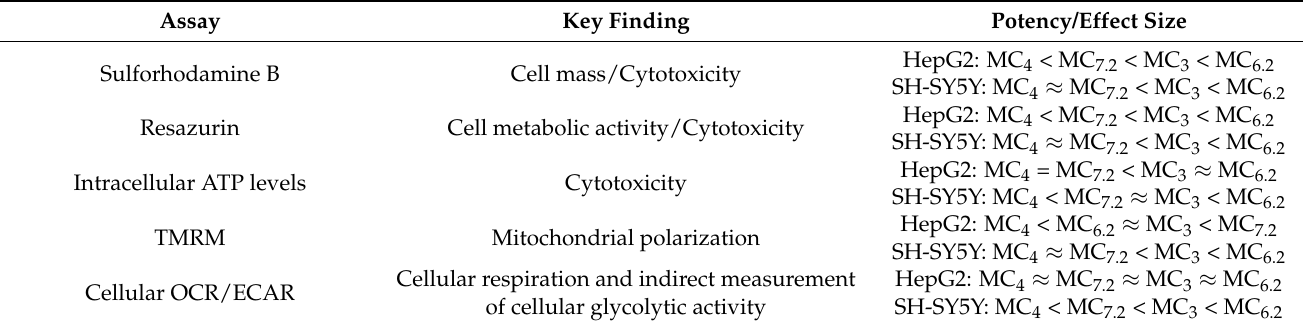
Table 1. Comparison of cytotoxicity and mitochondrial effects of MitoCIN compounds in HepG2 and differentiated SH-SY5Y cells. Assay Key Finding Potency/Effect